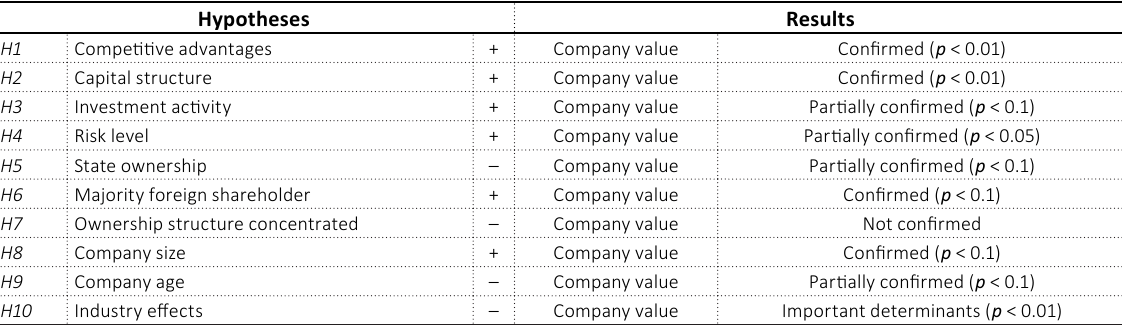
Table 2. Norms for assessing factors and cost drivers of Ukrainian companies Hypotheses Results